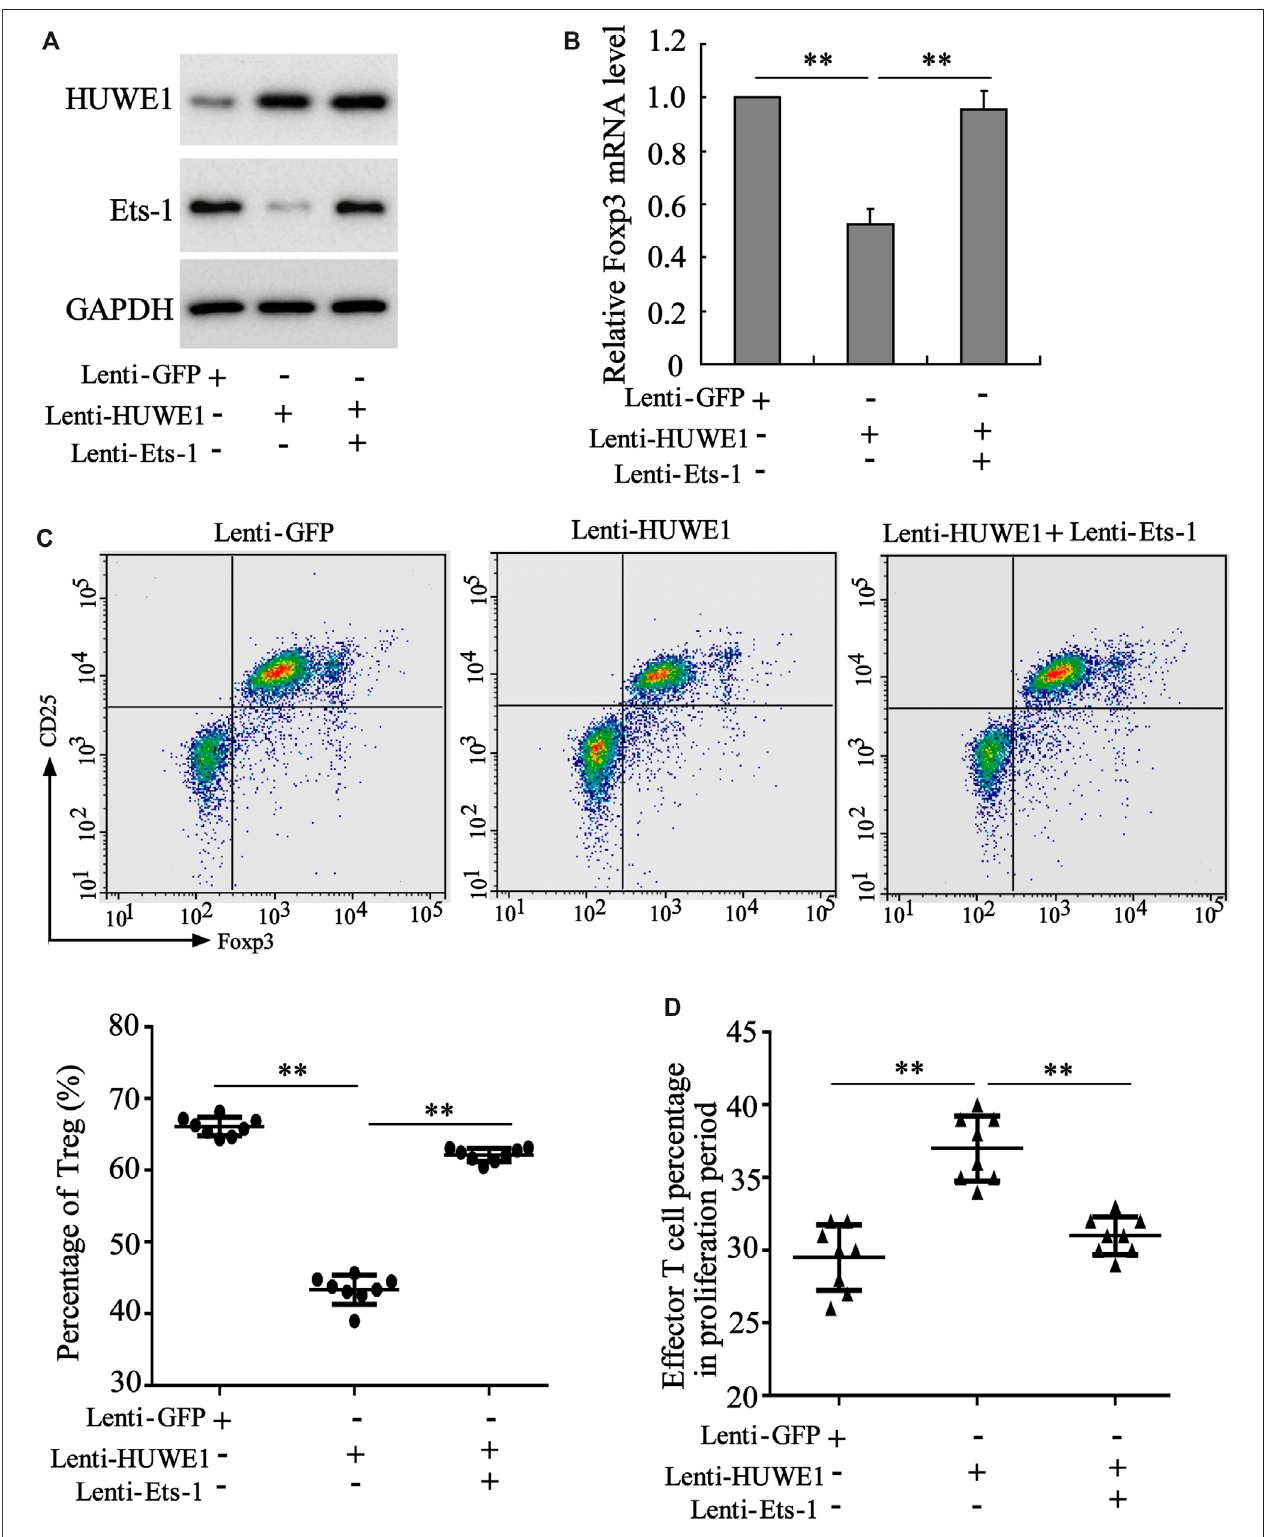
FIGURE 6 | Regulation of HUWE1 on the differentiation and function of Treg cells through Ets-1. Naive CD4 + T cells were isolated from the peripheral blood of healthy controls and transfected with HUWE1 lentivirus and/or Ets-1 lentivirus for 48 h, and were cultured in Treg polarization conditions (cells in the presence of plate-bound anti-CD3, solid anti-CD28, TGF β (5 ng/ml), and IL-2 (50 IU/ml) for 72 h. (A) Western blot was applied to measure the protein levels of HUWE1 and